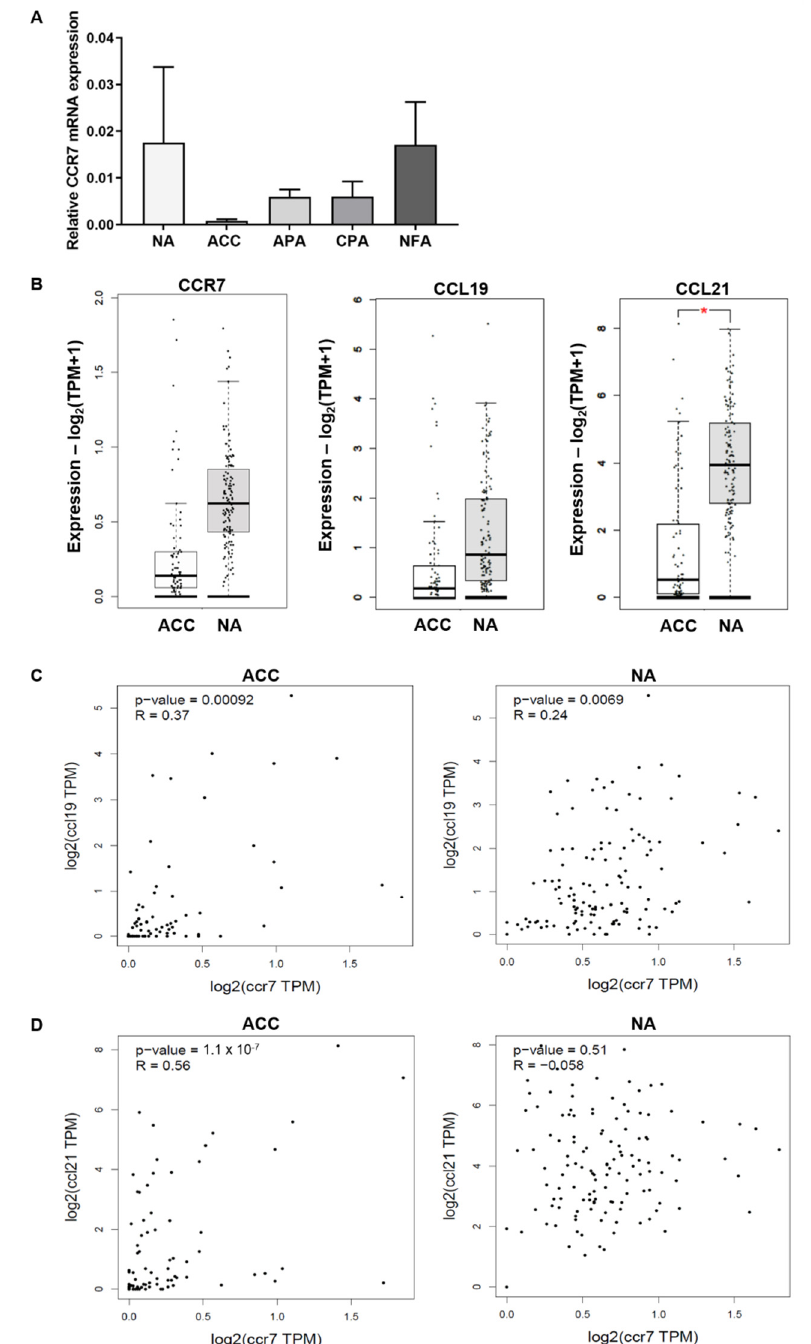
Figure 3. ( A ) Relative mRNA expression of CCR7 in normal adrenal (NA, n = 4), adrenocortical carcinoma (ACC, n = 9), aldosterone-producing adenoma (APA, n = 11), cortisol-producing adenoma (CPA, n = 10), and non-functioning adenoma (NFA, n = 3). Data is displayed as mean ± SEM. No significant differences were detected (Dunn’s multiple comparisons test). ( B ) mRNA expression data of CCR7 and its ligands CCL19 and CCL21 obtained from publicly available data sets using GEPIA2 (www.gepia2.cancer-pku.cn/; accessed 22 August 2021). Shown are adrenocortical carcinomas (ACC, n = 77) and normal adrenals (NA, n = 128). Significant differences were detected for CCL21 (one-way ANOVA). ( C , D ) Correlations of mRNA expression data for CCR7 and CCL19/21 for ACC and NA, respectively (GEPIA2, www.gepia2.cancer-pku.cn/, accessed 22 August 2021, Person’s correlation analysis).